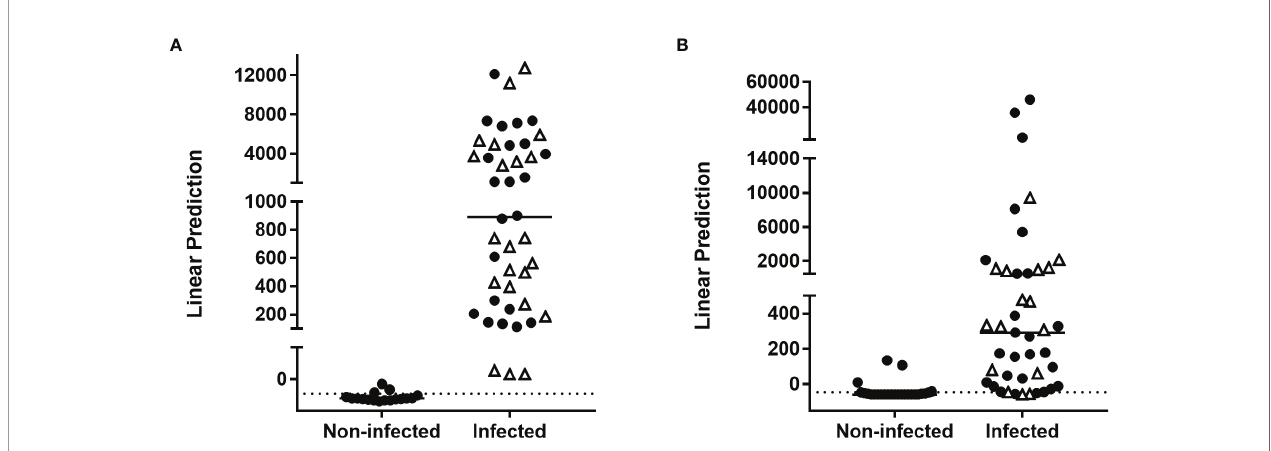
FIGURE 1 | Combination of M. tuberculosis -speci fi c immune markers allowing the distinction between M. tuberculosis -infected versus non-infected subjects in the PBMC assay. HBHA-IFN- g and ESAT-6-IFN- g were the markers selected by logistic regression analysis to be combined for the PBMC-based assay to discriminate M. tuberculosis -infected from non-infected subjects. Patients with aTB are indicated by open triangles. Results are represented with their linear predictor for the validation (A) and training (B) cohorts. The horizontal lines represent the medians and the dotted lines arbitrary cut-offs.